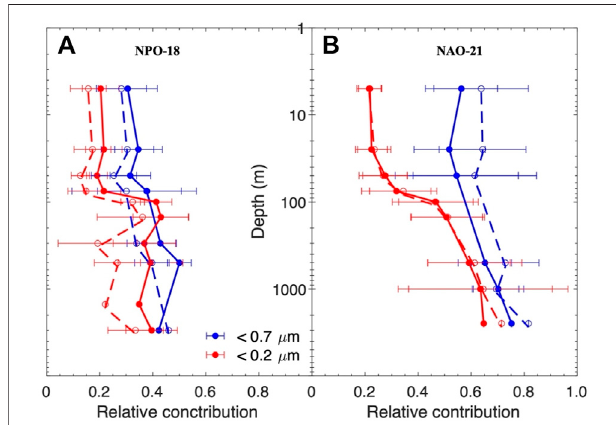
FIGURE 5 | Depth variation of relative contributions to bulk P 11 (solid circle + solid line) and P 12 (open circle + dash line) at 120 ° by submicron particles in the (A) NPO-18 and (B) NAO-21 sites.